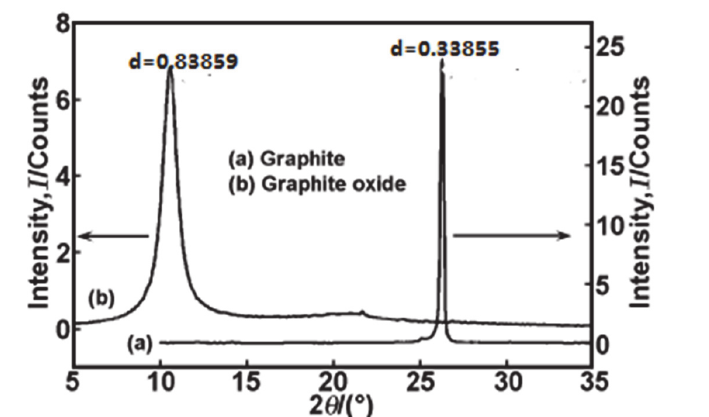
Figure 1: The XRD spectra of graphite and graphite oxide.